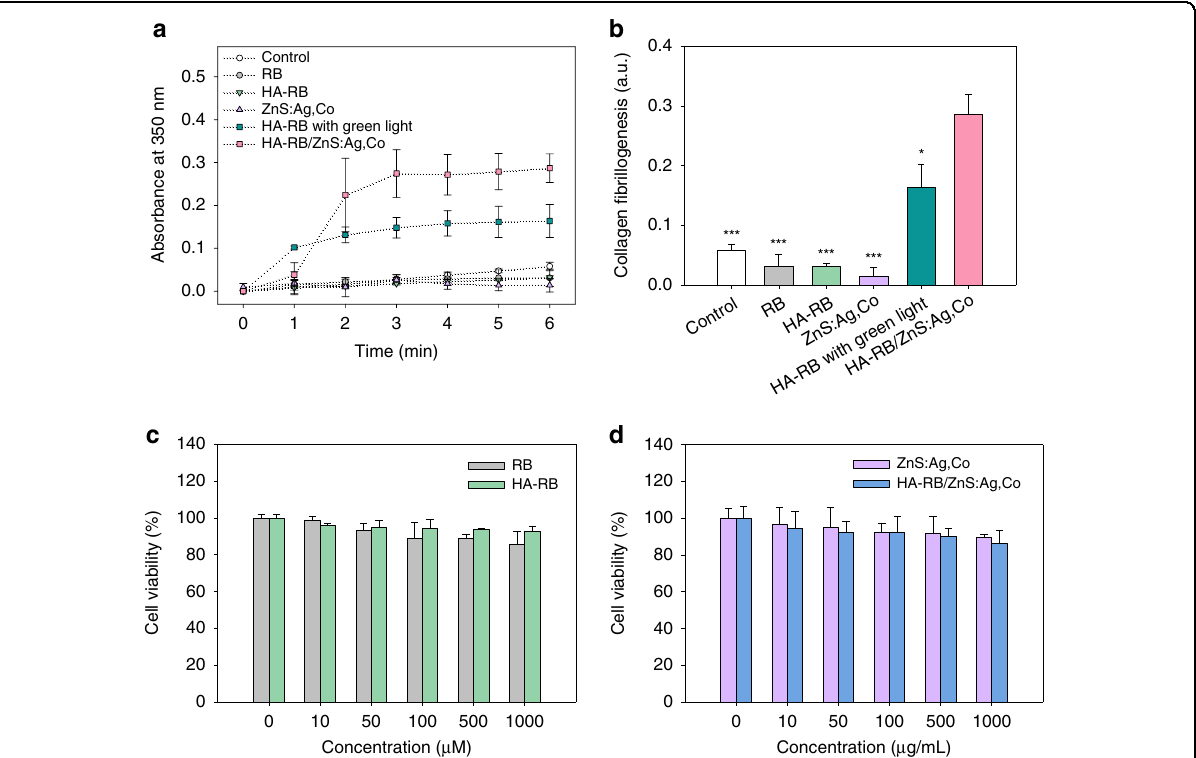
Fig. 5 Collagen fi brillogenesis and biocompatibility of HA-RB/ZnS:Ag,Co mixtures. a The degree of collagen crosslinking by monitoring the optical density at 350 nm after treatment with the control (DI water), RB, HA-RB conjugates, ZnS:Ag,Co particles, or HA-RB/ZnS:Ag,Co mixtures for 6 min under on-off fractional irradiation of UV light. Experimental conditions were the same for the case of HA-RB conjugates with green light. b The relative increase of optical density at 6 min after treatment with samples in a ( n = 3, * P < 0.05, *** P < 0.001 versus HA-RB/ZnS:Ag,Co mixture). The relative viability of NIH3T3 cells treated with c RB or HA-RB conjugates, and d ZnS:Ag,Co particles or HA-RB/ZnS:Ag,Co mixtures by CCK-8 assay ( n = 3). Data are expressed as mean ±